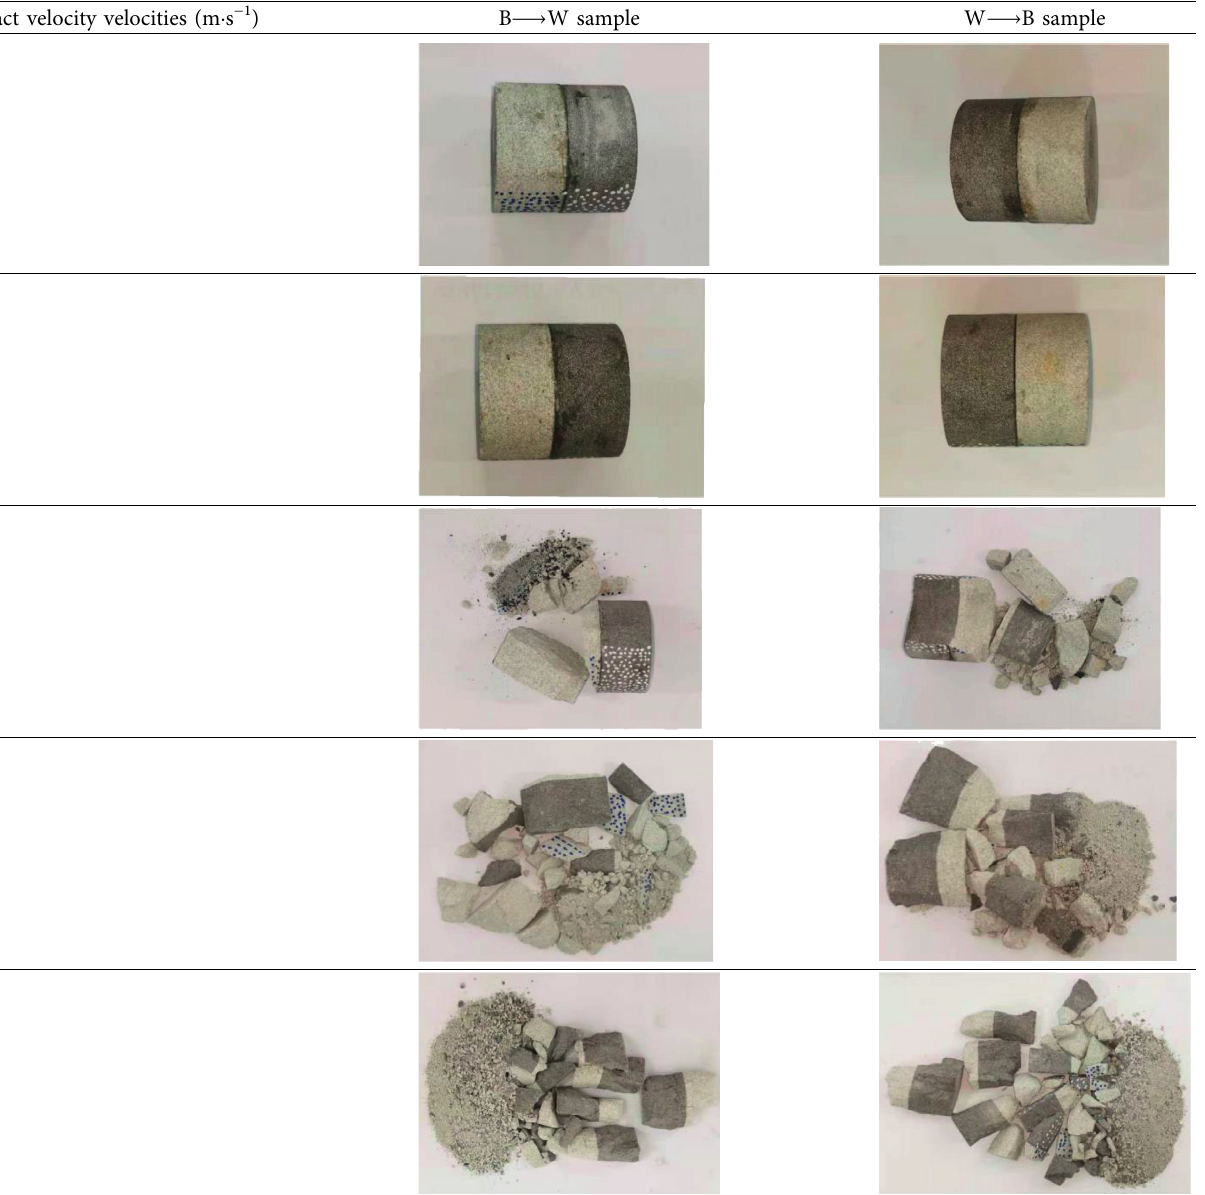
Table 3: Broken morphology of layered composite rock